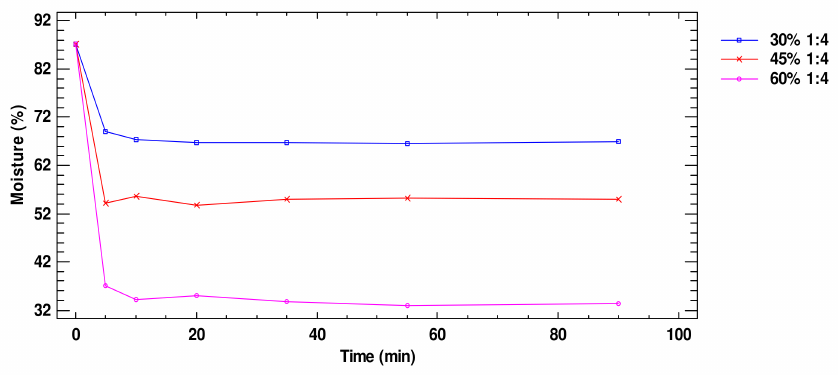
Figure 7. Moisture during